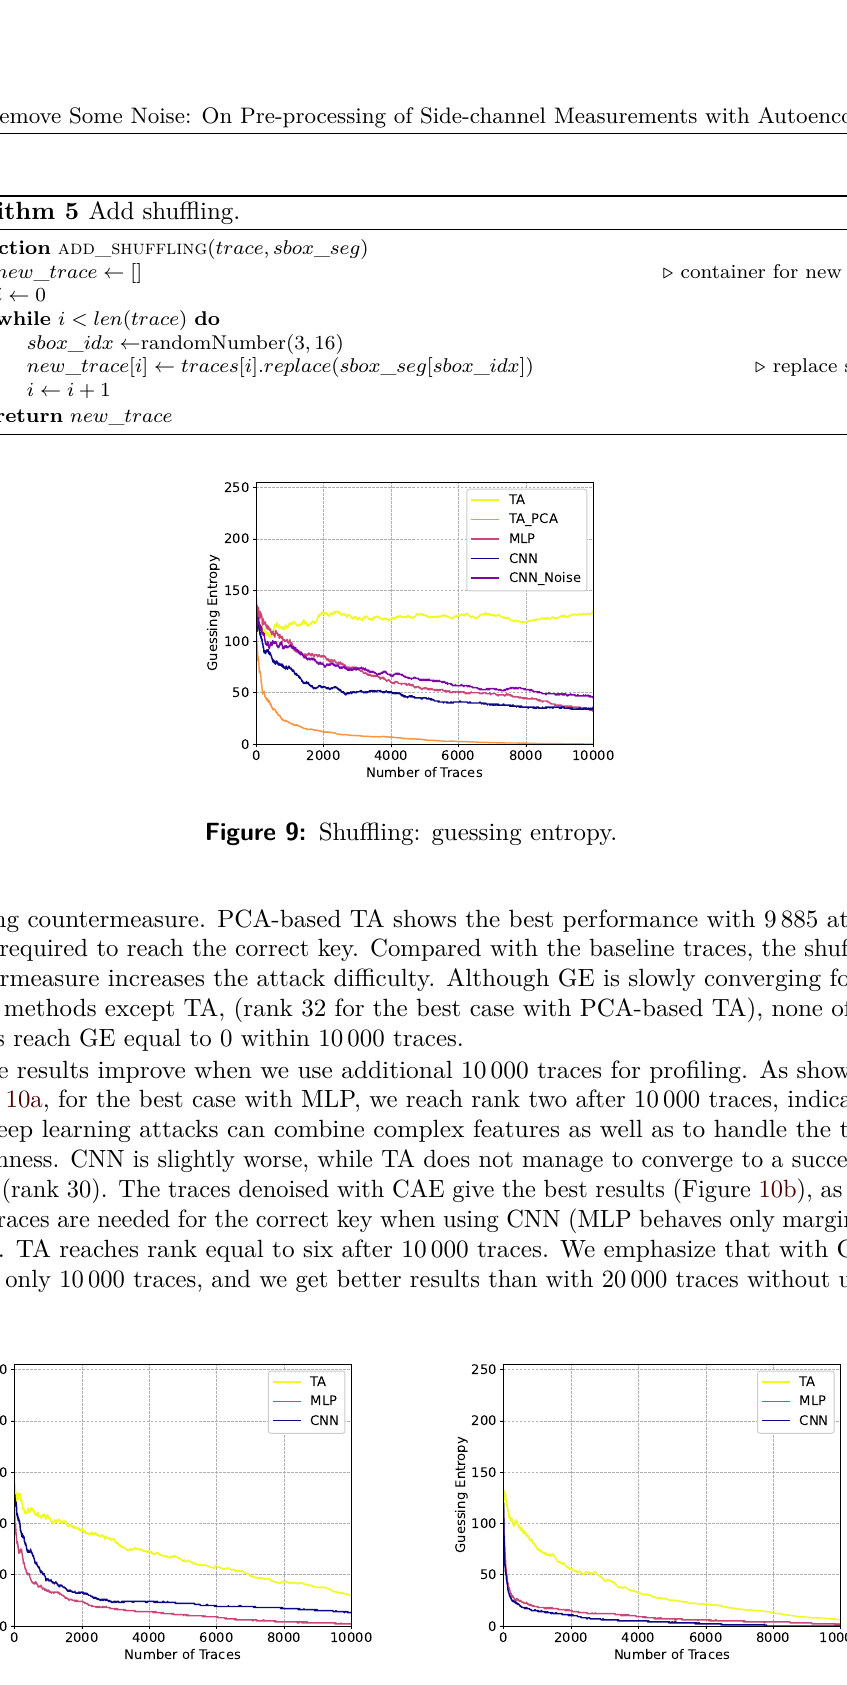
(b) GE: denoised with CAE. Figure 10: Guessing entropy: denoising shuffling by applying more traces (a) or CAE